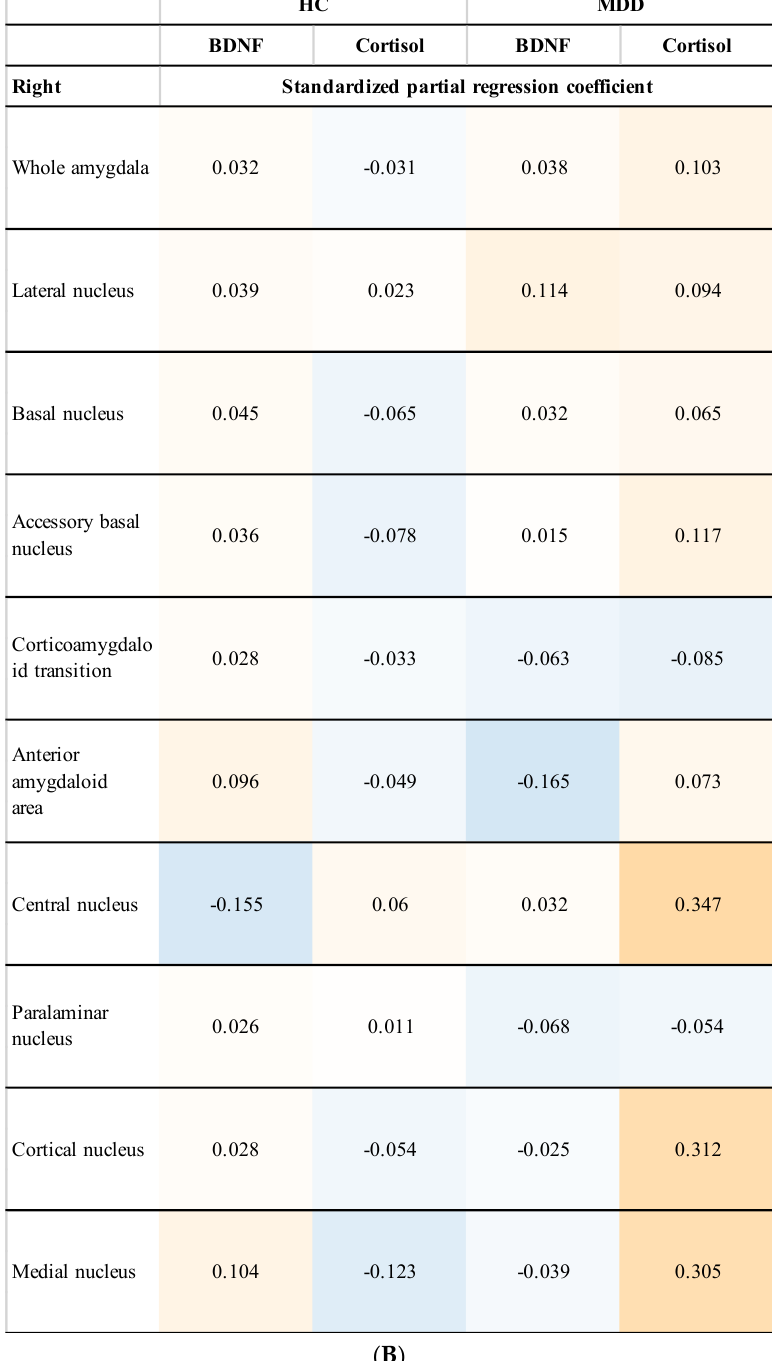
Figure 3. Relationship between left ( A ) and right ( B ) amygdala volume and plasma levels of BDNF and cortisol (Subgroup analysis). Plasma levels of cortisol were significantly positively correlated with the left medial nucleus (β = 0.548, p = 0.0082) ( A ) and right central nucleus (β = 0.347, p = 0.043) ( B ) in the MDD group, however, correction for multiple comparisons failed to show statistically significant differences. Positive correlations are shown in orange, negative correlations are shown in blue, and the strength of the correlation is expressed in terms of concentration (−1.0–1.0).